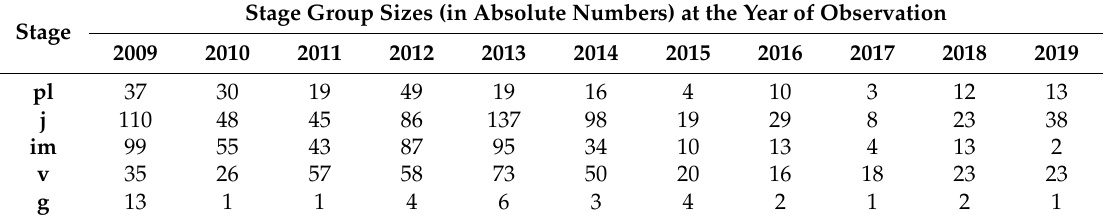
Table 1. Structure of the local A. albana population according to observation data (Table 1 in [36]).